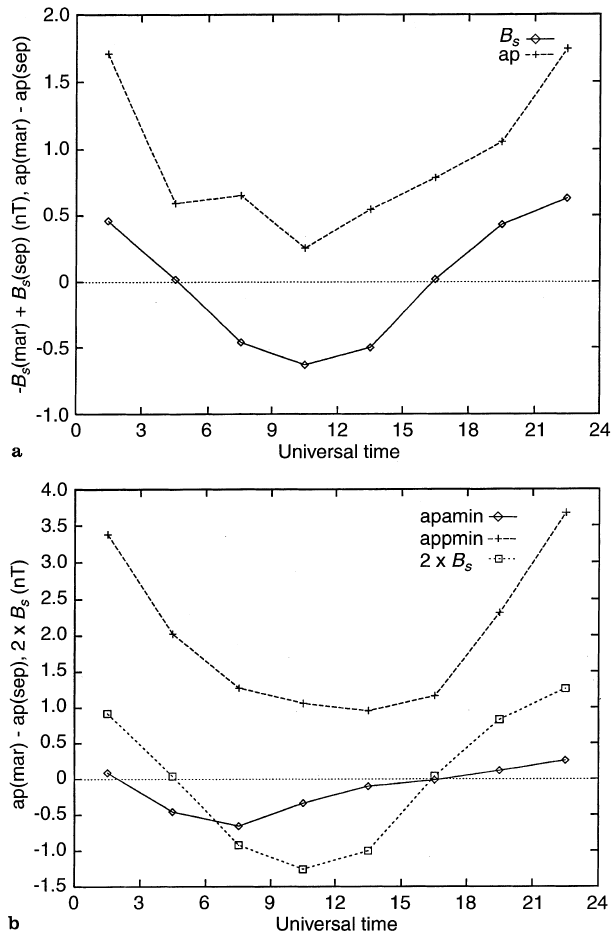
Fig. 6. a Di(cid:128)erence of the March and September UT variations of the IMF southward component B s as predicted by the Russell-McPher- ron e(cid:128)ect (cid:255) B s (mar) (cid:135) B s (sep) and the respective di(cid:128)erence of the UT variations of ap (years 1933–1993) ap (mar) ) ap (sep); the sign of the B s curve was chosen so that the minimum at 10:30 UT matches the minimum of the ap curve. b Di(cid:128)erence of the vernal and autumnal UT variations of ap for the same groups of years before (apamin) and after (appmin) sunspot minimum as in Figs 4 and 5 together with the UT variation of B s of Fig. 6a multiplied by a factor